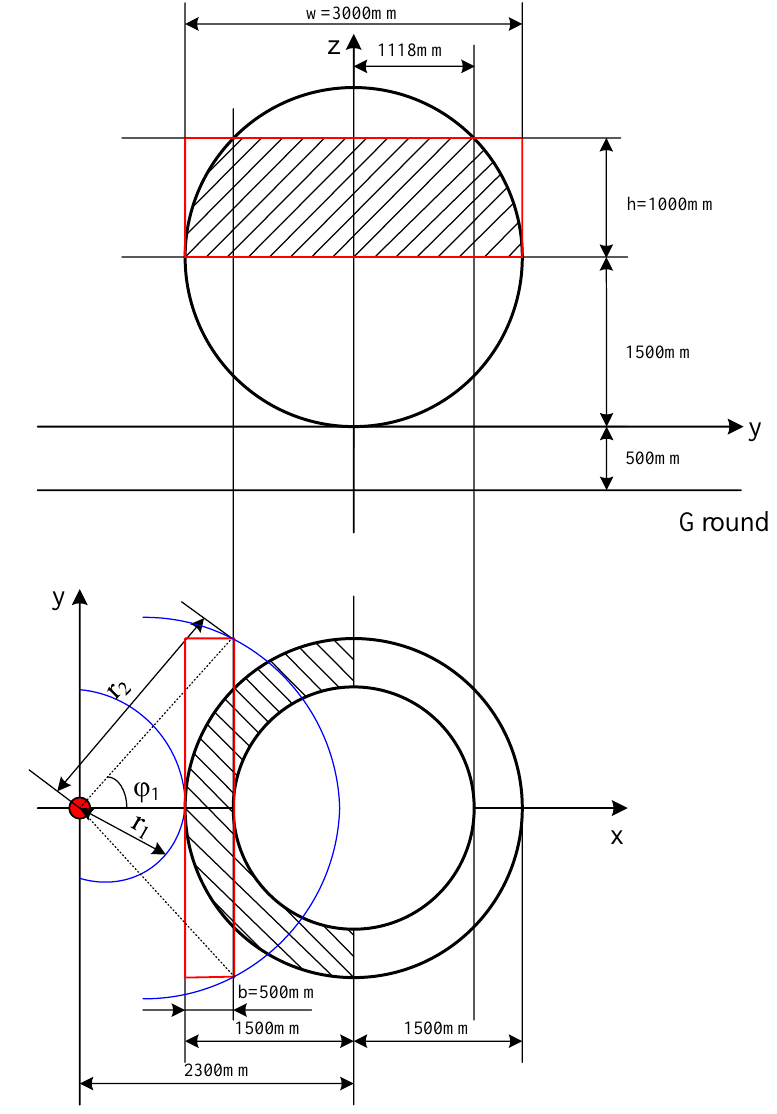
Figure 4. View of the simplified working space.